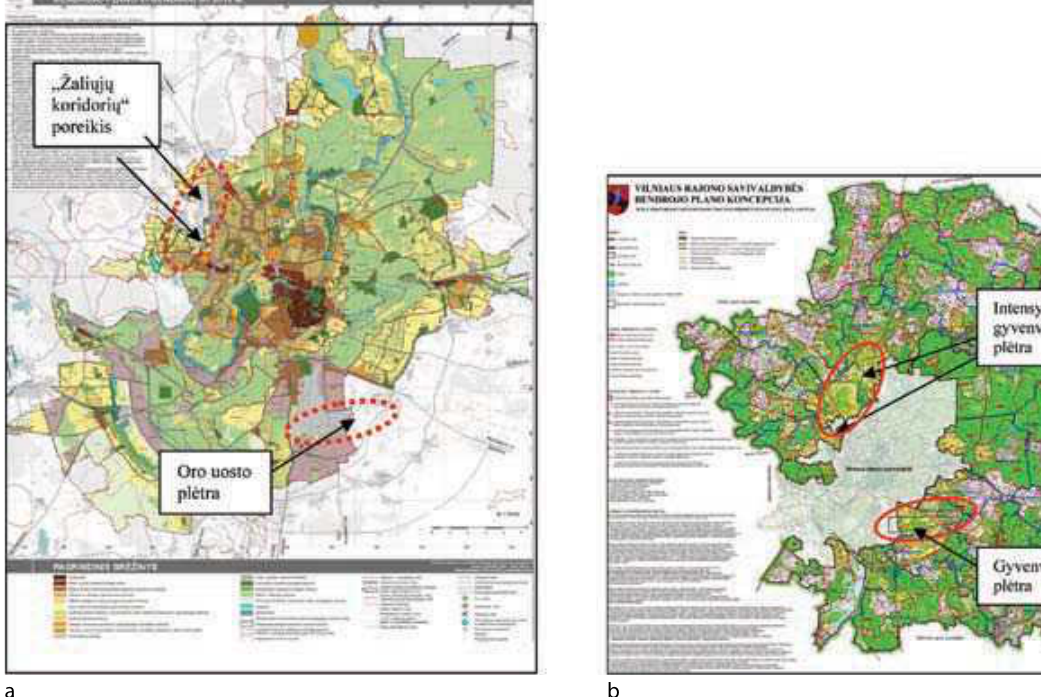
1 pav. Miesto ir priemiesčio plėtros koordinacijos problemos: a – Vilniaus miesto (rygos ... 2006–2018); b – Vilniaus rajono (Vilniaus rajono savivaldybės ... 2008) savivaldybių plėtros planai Fig. 1. coordination problems between development plans of Vilnius city (rygos ... 2006–2018); and Vilnius district (Vilniaus rajono savivaldybės ...